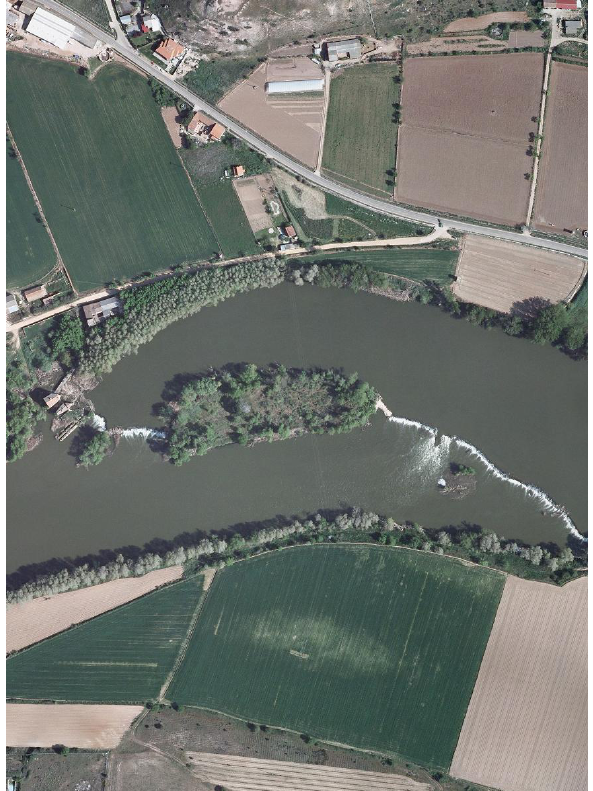
Figure 1: Environmental approach from aerial